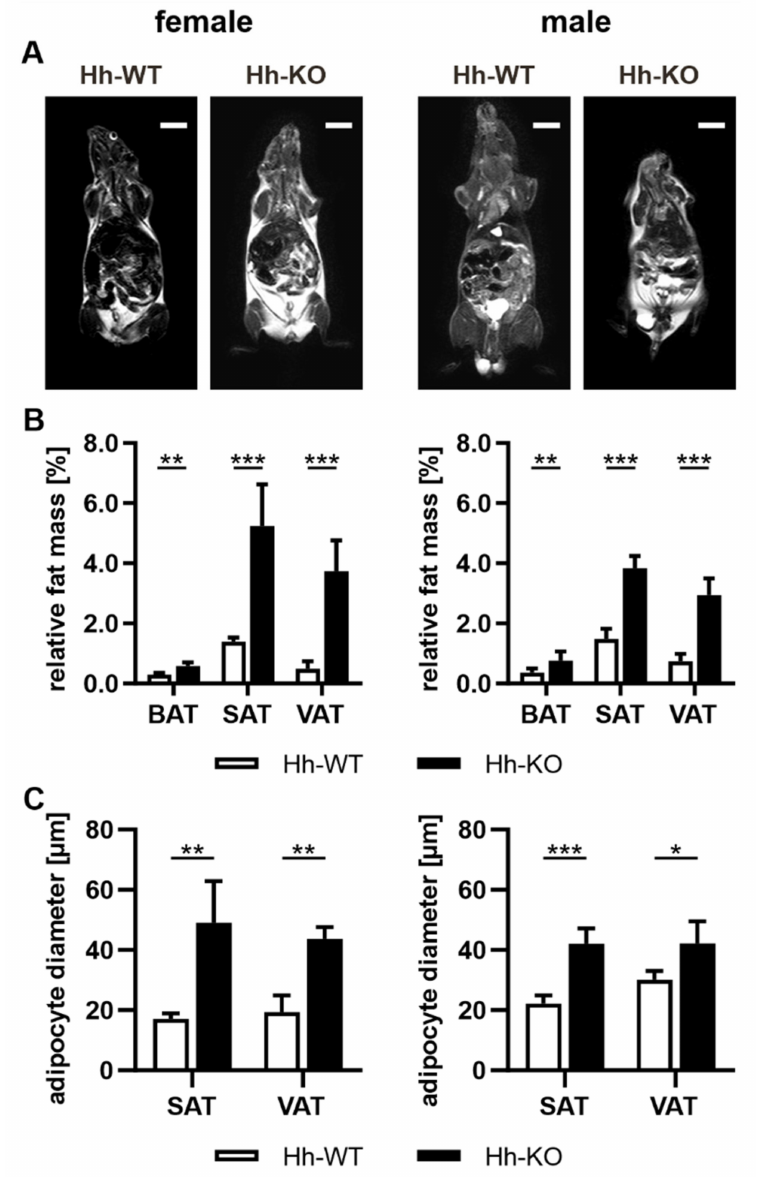
Figure 1. Phenotypic changes in adipose tissue in Hh mice. ( A ) MRI scans showing adipose tissue depots as white areas in female and male Hh-WT and Hh-KO mice. Scale bars indicate 10 mm. ( B ) Quantitative analysis of brown (BAT), subcutaneous (SAT) and visceral (VAT) adipose tissue plotted as a percentage of body weight in female and male Hh-WT and Hh-KO mice; n = 4–7. ( C ) Analysis of adipocyte diameter based on perilipin staining (more details in Figure S2) in SAT and VAT from female and male Hh-WT and Hh-KO mice; n = 3–4. Multiple unpaired t-tests with p -values * ≤ 0.05, ** ≤ 0.01, *** ≤